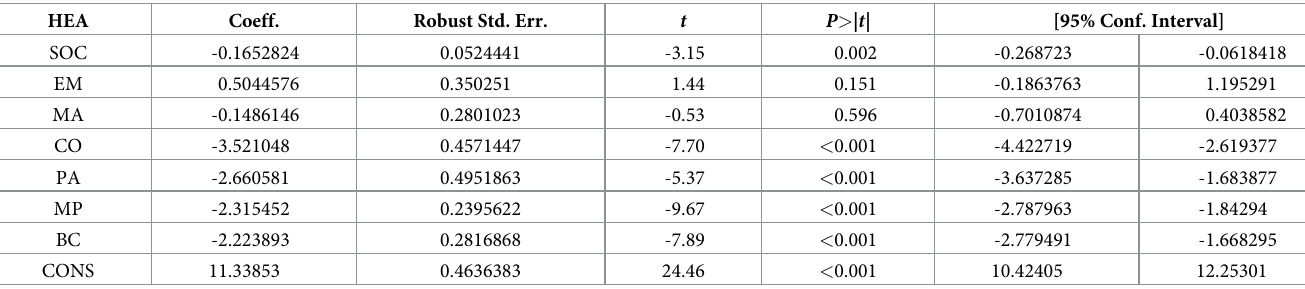
Table 4. The empirical estimation of the individual health (HEA) costs for social benefits (SOC) using Eq 6. HEA Coeff. Robust Std. Err. t P > | t| [95% Conf. Interval] SOC